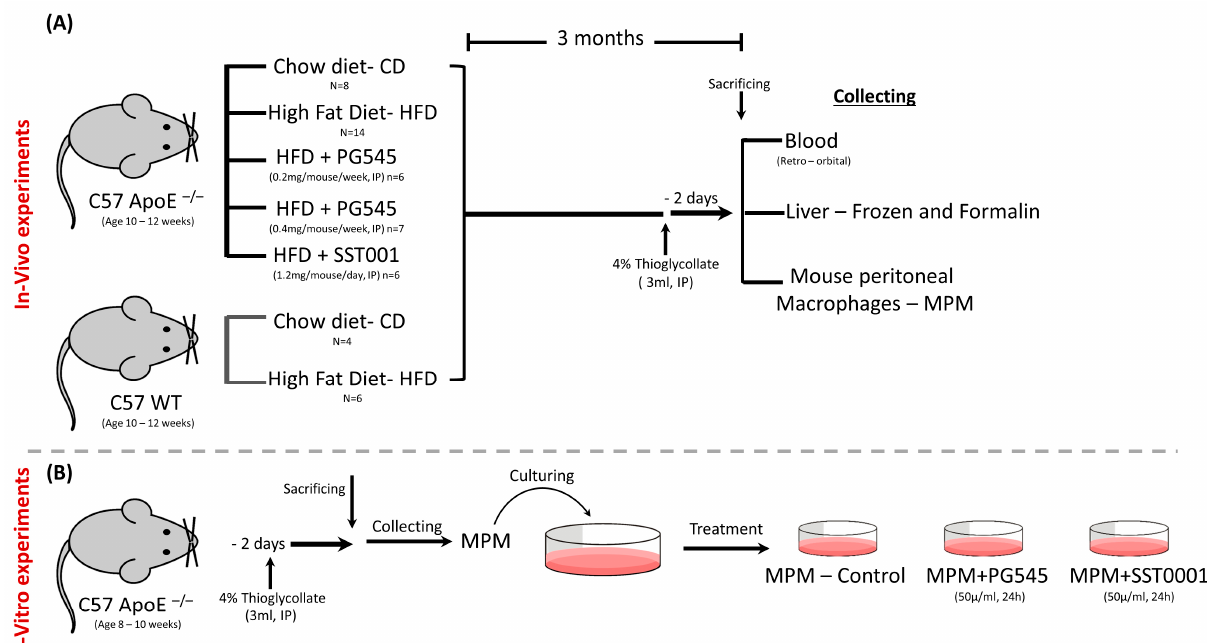
Figure 1. Study methodology. ( A ) In vivo experiments. C57 ApoE − / − mice were placed on CD or HFD; the latter were treated with PG545 in two doses, SST0001 or NS. C57 WT mice were placed on either CD or HFD. Mice were then sacrificed, and blood, livers, and MPMs were collected for analysis. ( B ) In vitro experiments. MPMs were collected from C57 ApoE − / − mice, treated with PG545 or SST0001 and tested for lipid content and beta-oxidation of lipids.